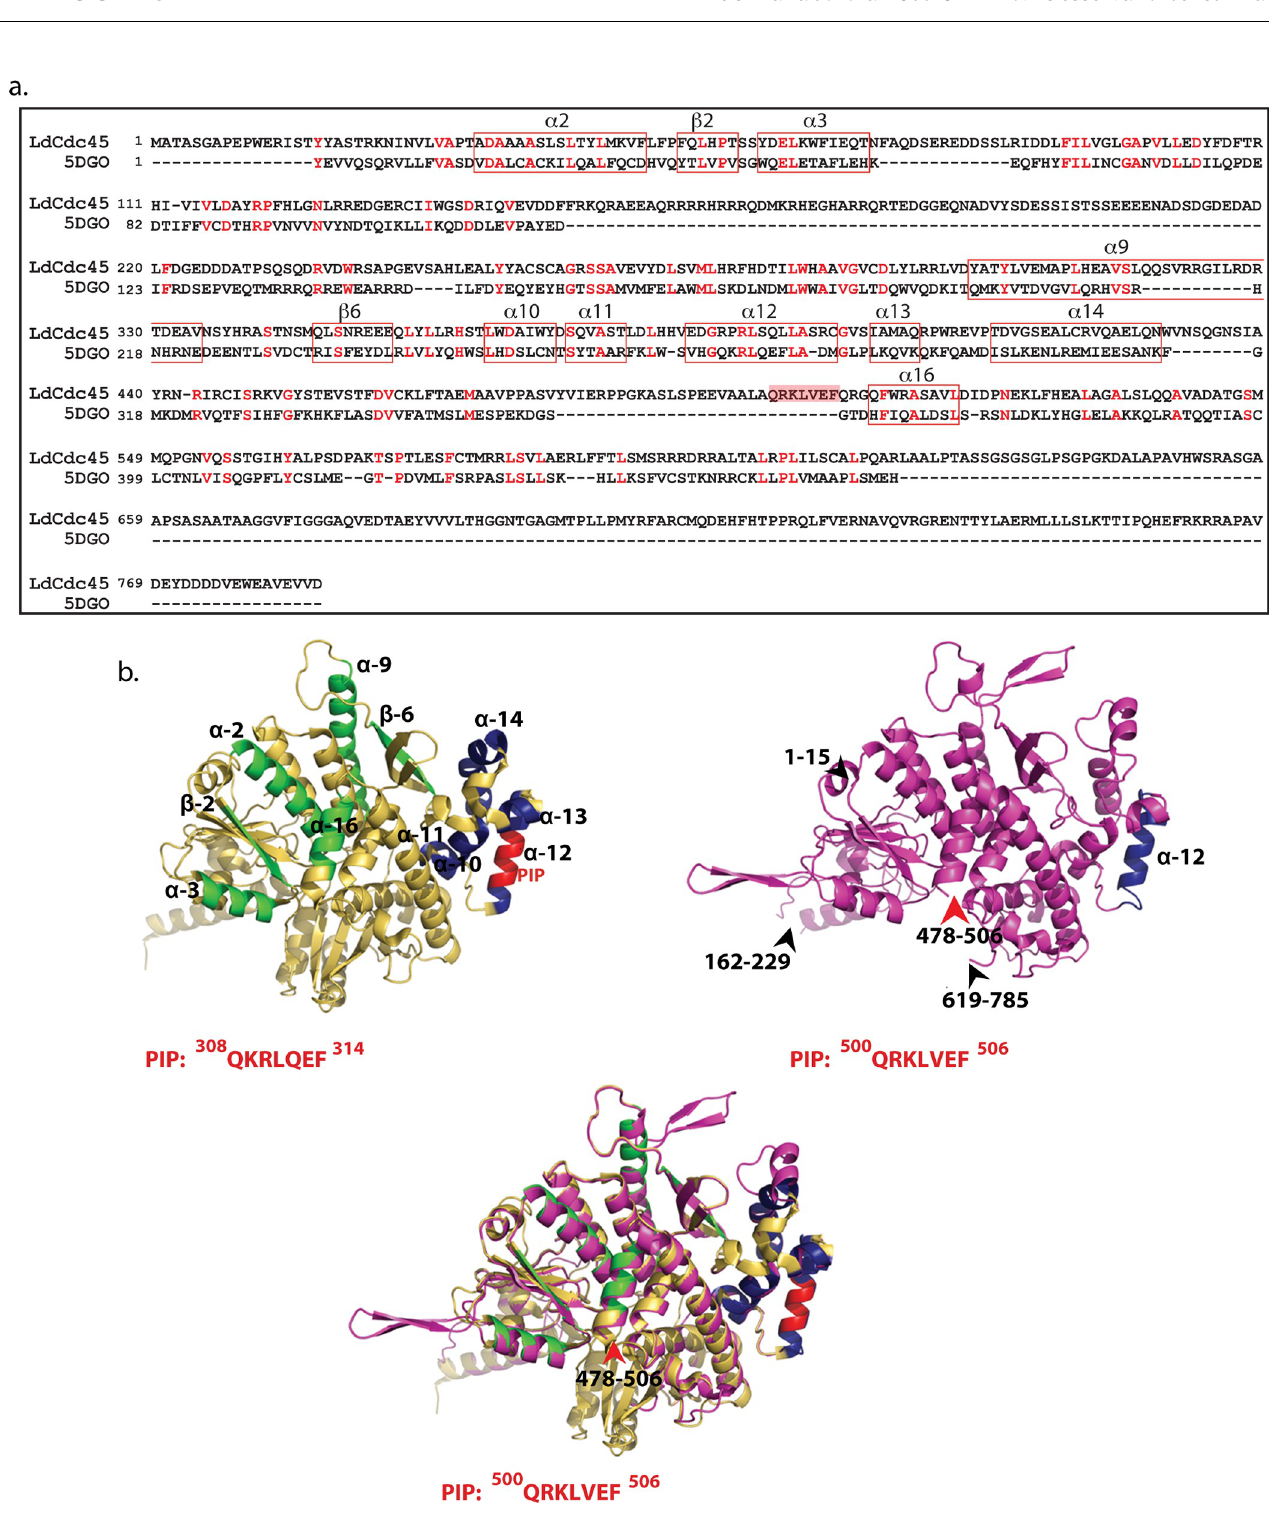
PLOS Pathogens| https://doi.org/10.1371/journal.ppat.1008190 May 15, 2020 8 /